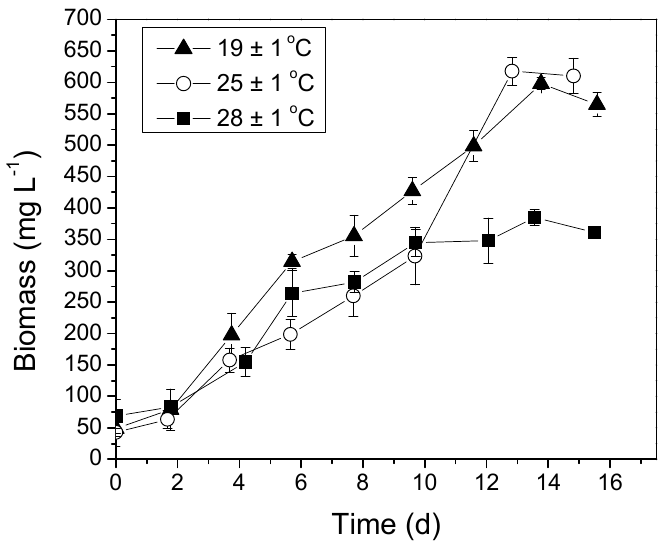
Figure 4. Effect of temperature on the biomass production of T. striata .